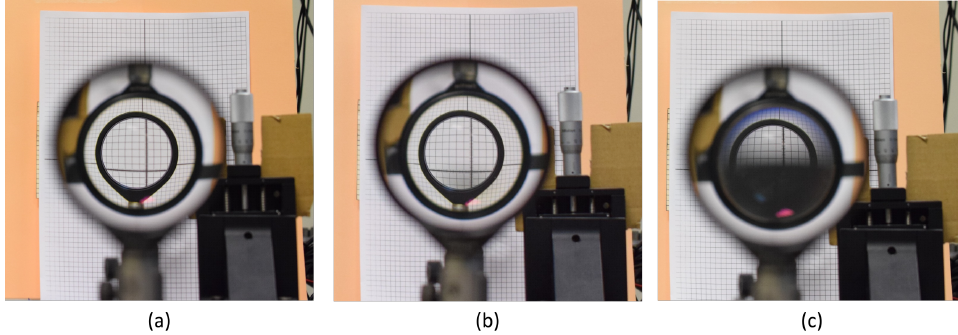
Figure 4. Photographs taken of the experimental system, in the cases when the object was invisible and when it was not, in the first zone for f 3 = − 150 mm. ( a ) Invisible object. ( b ) Height limit. The object begins to be visible. ( c ) Visible